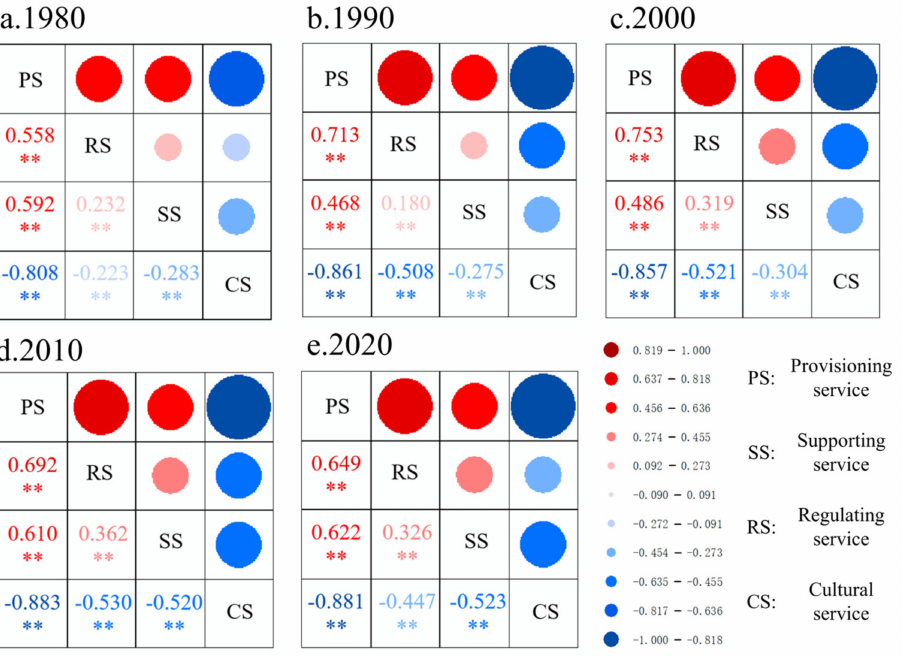
Figure 9. Correlations of four categories of ecosystem services (** represents p < 0.01) in the Yellow River Delta, 1980–2020. The lower left part of each panel shows the Spearman’s correlation coefficients. The blue and red symbols represent negative and positive correlations,